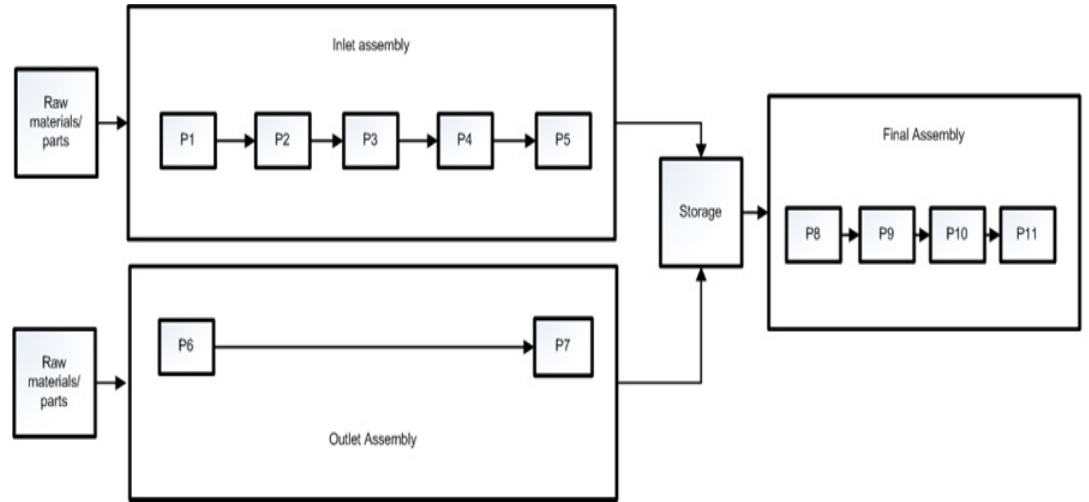
Figure 1: Process map of welding operations involved in catalytic converter manufacturing process.